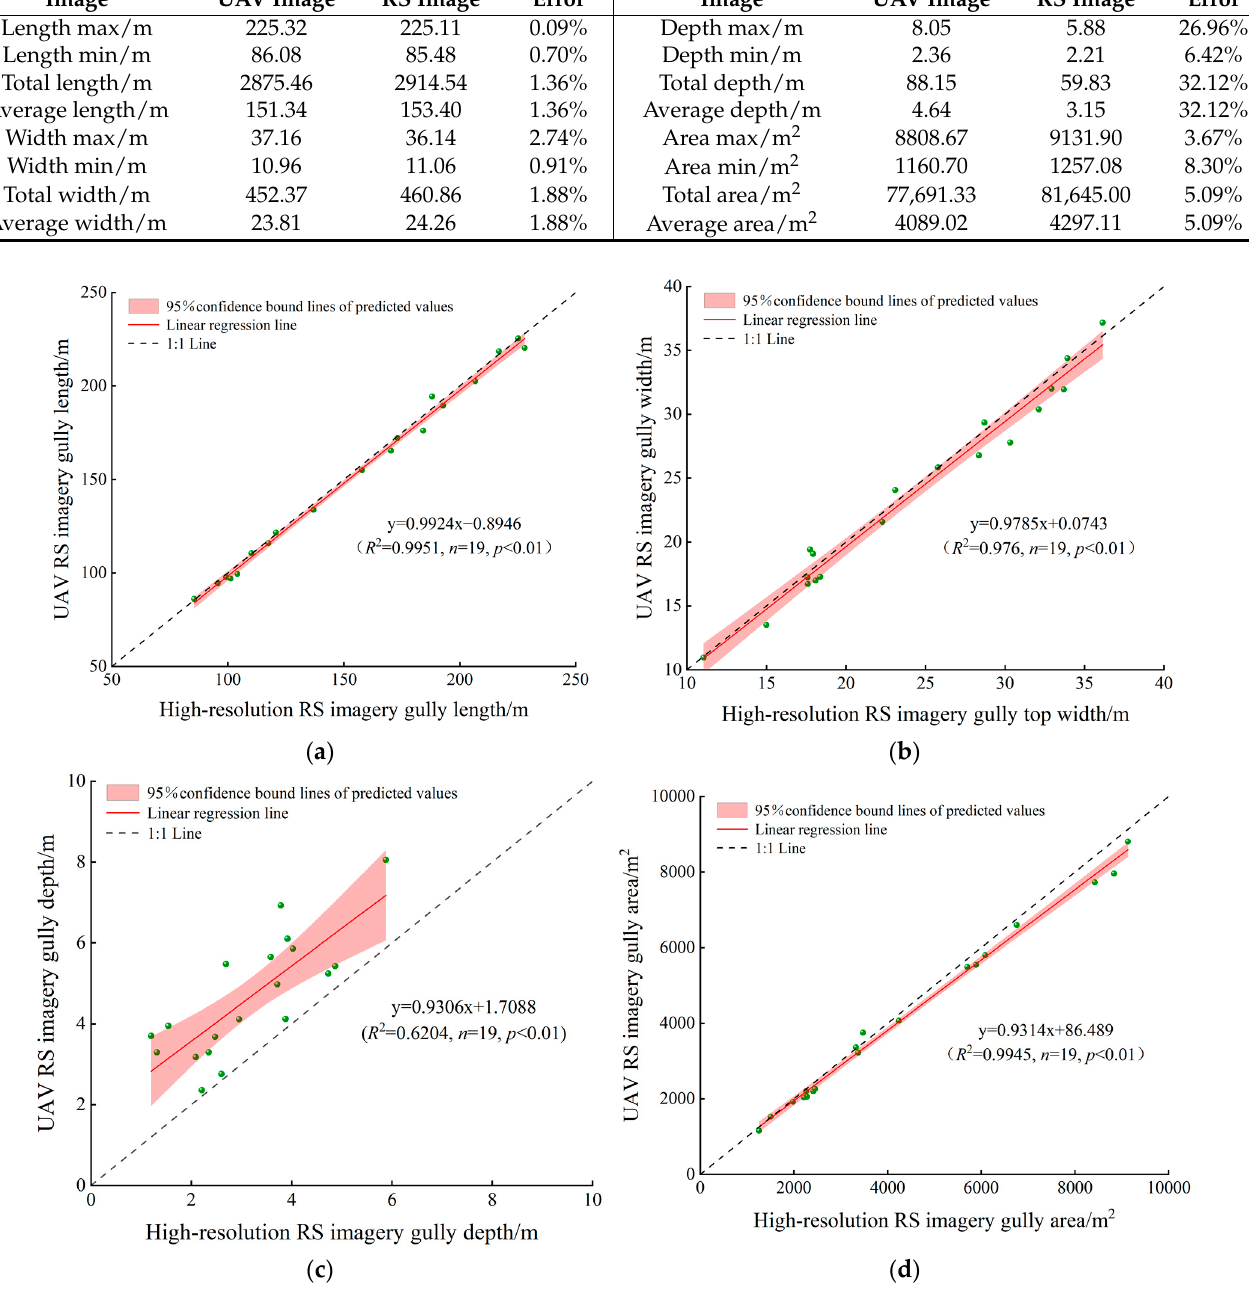
Figure 5. Linear regression model for error correction of 3D morphological parameters of the gullies: ( a ) Gully length error correction; ( b ) Gully top width error correction; ( c ) Gully depth error correction; ( d ) Gully area error correction.